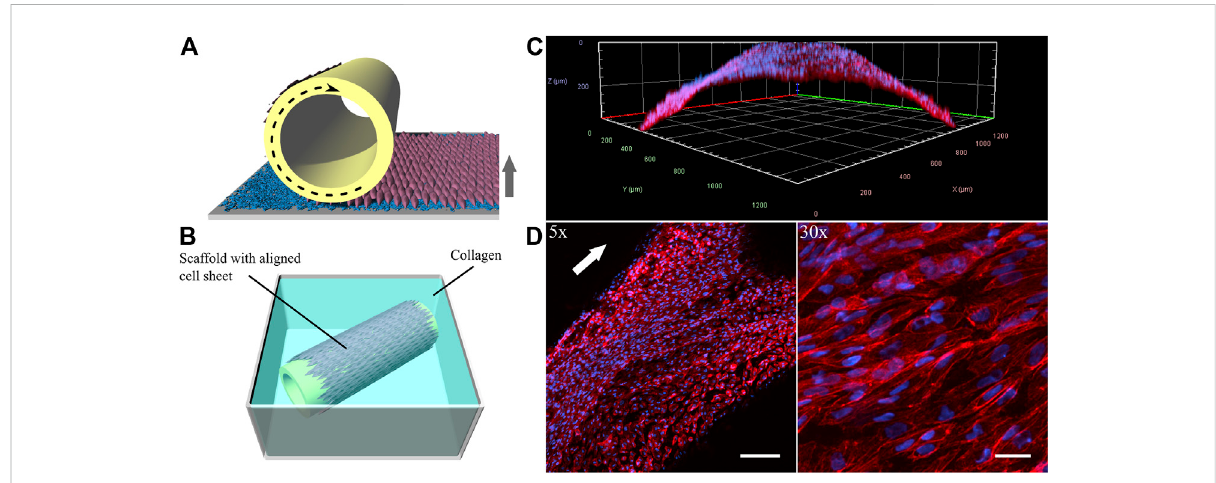
FIGURE 10 Generationofvessel-likeconstructsbytransferringadetachingalignedendothelialsheetfromaPGE-coatedthermoresponsivesubstrateonto a tubular 3D-printed scaffold. (A) Illustration of wrapping process and (B) rolled sheet on scaffold embedded in a collagen gel. (C) 3-dimensional reconstruction and (D) Z-projection of confocal stacks of the phalloidin-stained (red) iPSC-EC sheet at different magni fi cations. Nuclei were counterstained with Hoechst 33342 (blue). Cell sheet was detached and rolled after 96 h of dynamic culture. (Arrows indicate fl ow direction. Scale bars: 5× 200 µm, 30× 30